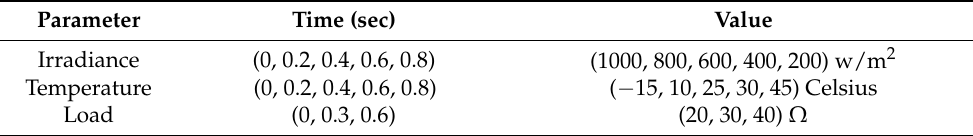
Table 2. Table showing the variation of